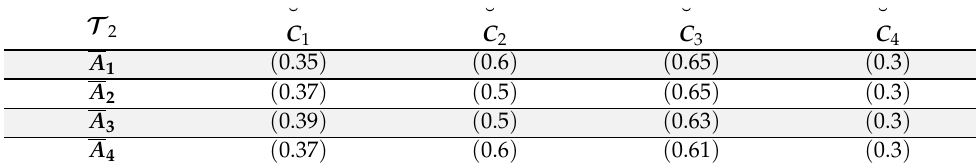
Table 8. Decision matrix, which calculates the value of T 2 .